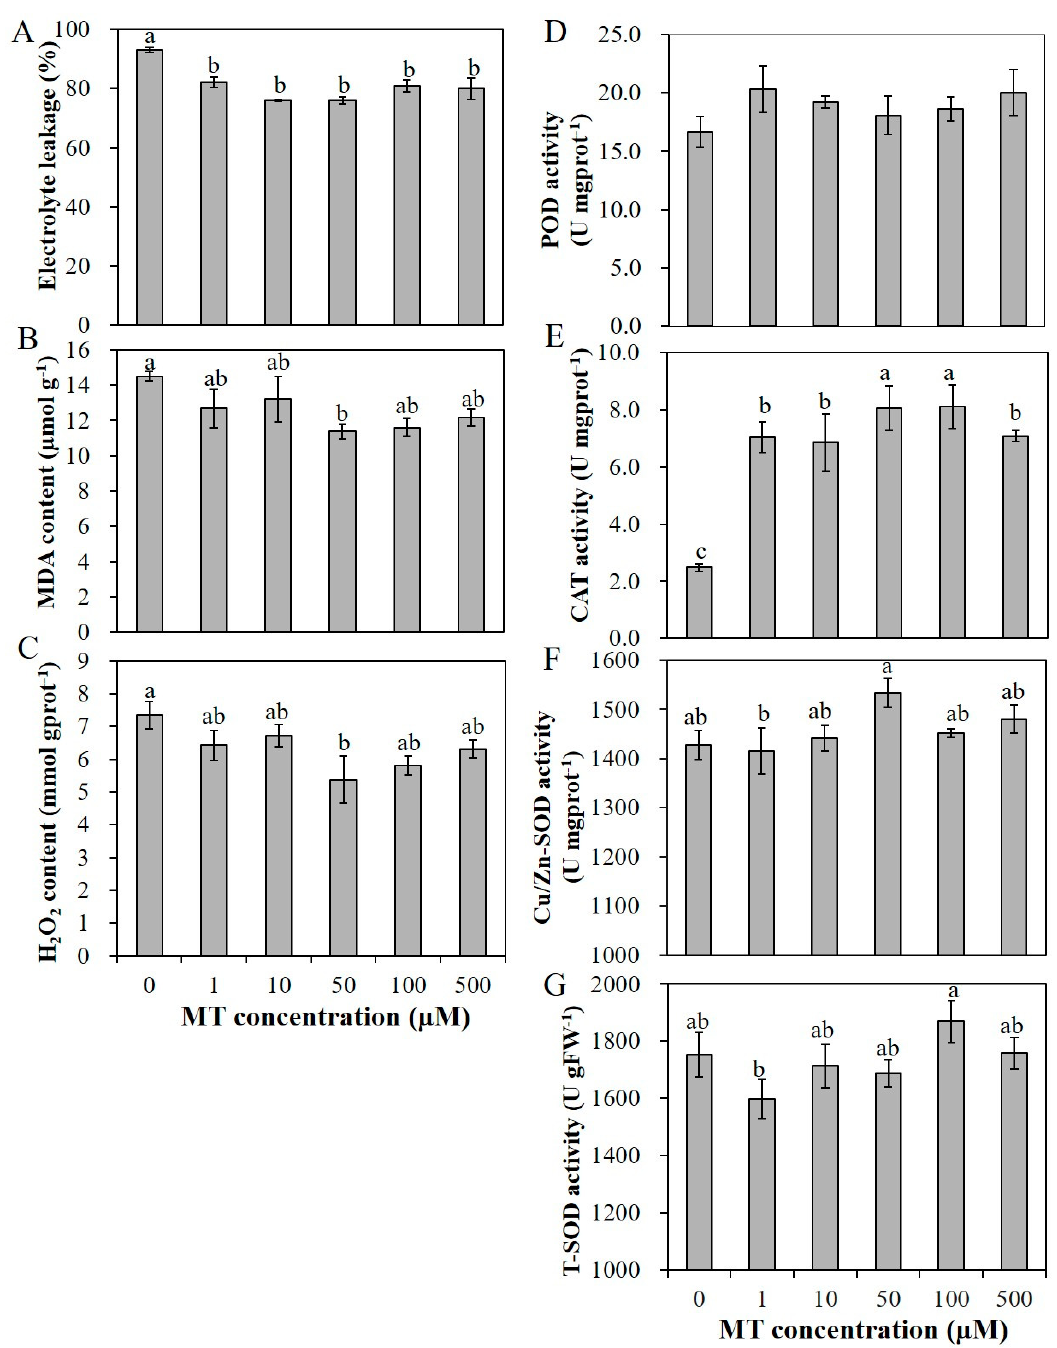
Figure 3. The mitigated effects of various concentrations of MT (0, 1, 10, 50, 100 and 500 µM) on electrolyte leakage ( A ), malondialdehyde (MDA) content ( B ), H 2 O 2 content ( C ) and the enzyme activities of peroxidase (POD) ( D ), catalase (CAT) ( E ), Cu/Zn superoxide dismutase (Cu/Zn-SOD) ( F ), and T-SOD ( G ) of alfalfa seedlings under 200 mM NaCl salinity condition. Data are represented as means ± SE ( n = 3), and bars with different letters indicate the differences between these different treatment groups according to ANOVA analysis ( p < 0.05).